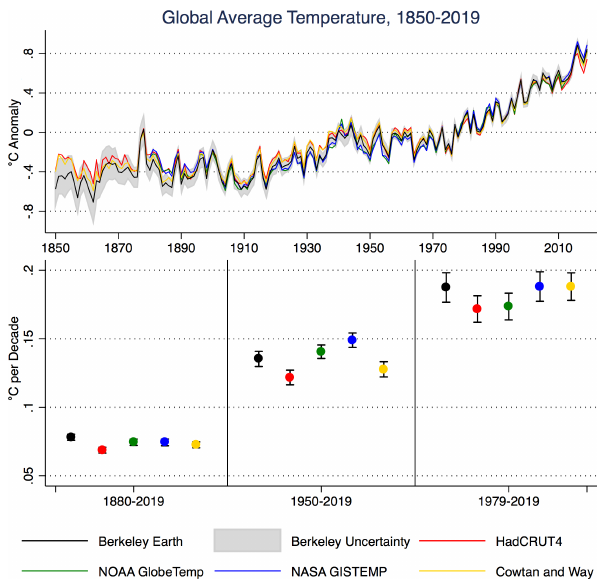
Figure 3. Comparison of published global surface temperature records. The top panel shows annual anomalies (relative to a 1961– 1990 baseline period), with the Berkeley Earth uncertainty as the shaded area. The bottom panel shows trends and two-sigma trend uncertainties (calculated using an autoregressive–moving average, ARMA(1,1), approach to account for autocorrelation) for various starting dates through the end of 2015 based on monthly